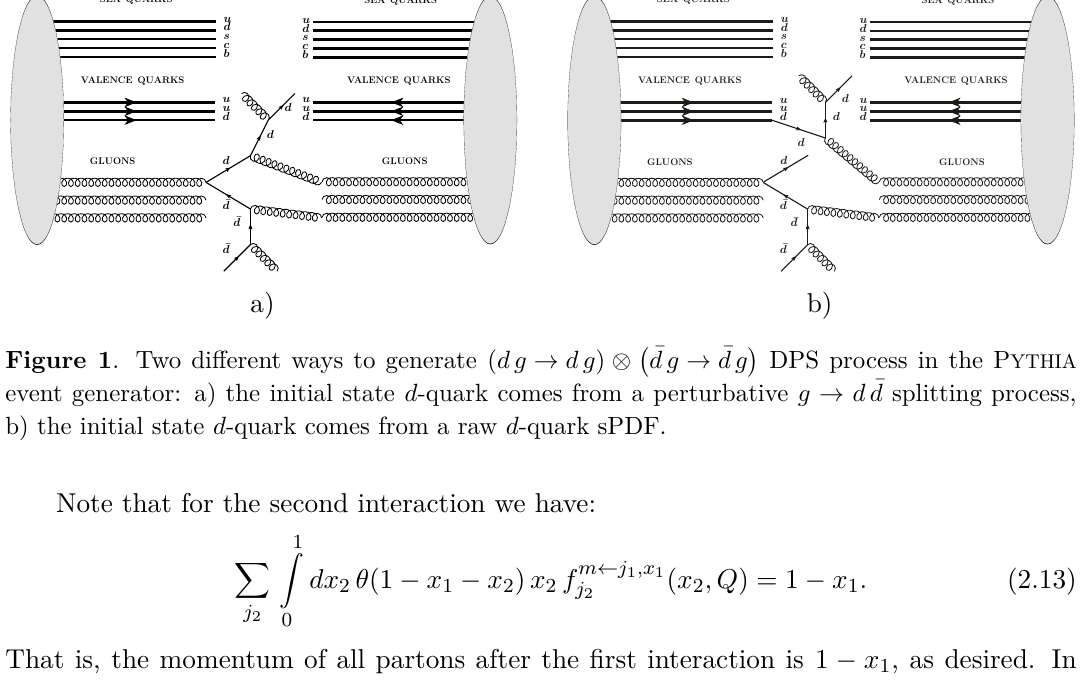
Figure 1 . Two different ways to generate ( d g → d g ) ⊗ event generator: a) the initial state d -quark comes from a perturbative g → d ¯ d splitting process, b) the initial state d -quark comes from a raw d -quark